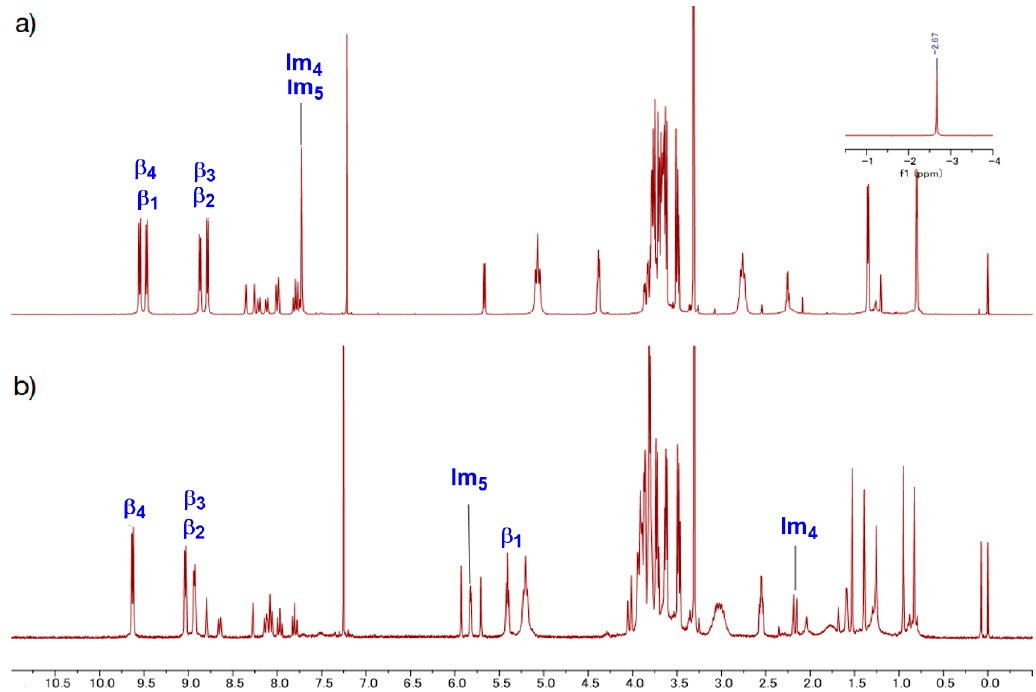
Figure 8. 1 H-NMR (400 MHz, CDCl 3 ) of free-base porphyrin 5 and coordination dimer of zinc porphyrin 5Zn .